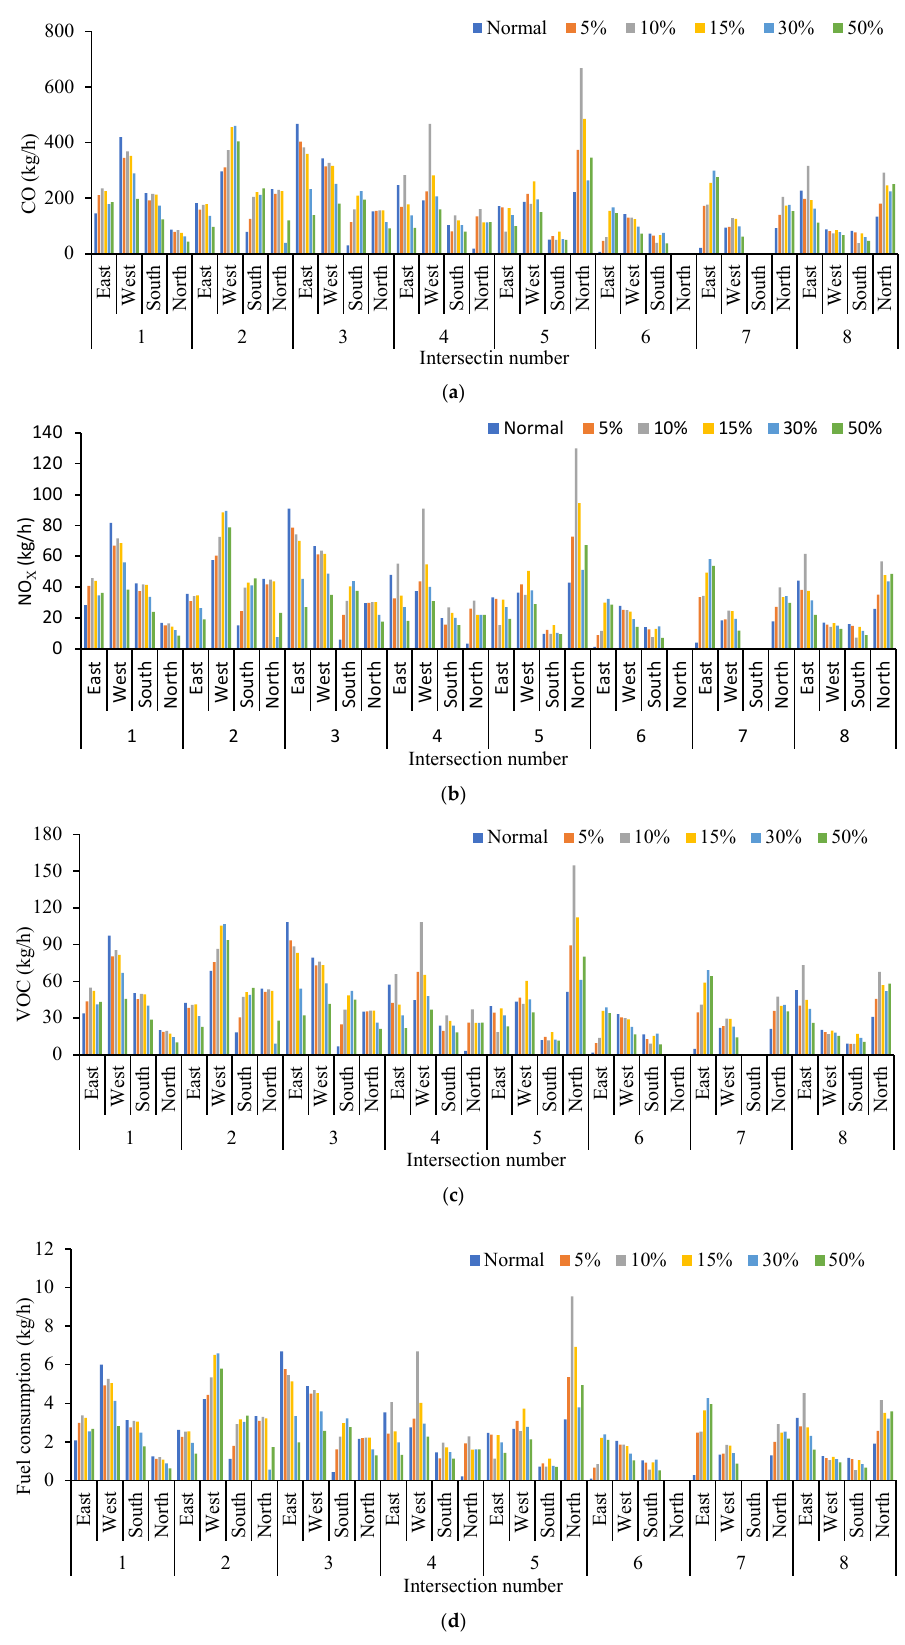
Figure 18. Comparison of four indicators at different intersections. ( a ) Comparison of CO emission at different intersections. ( b ) Comparison of NO X emission at different intersections. ( c ) Comparison of VOC emission at different intersections. ( d ) Comparison of fuel consumption at different inter- sections.